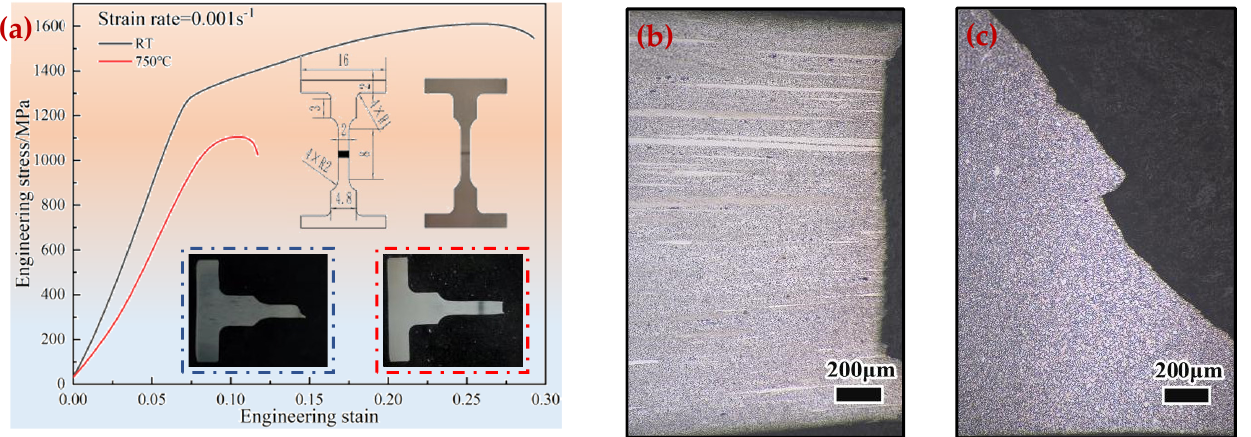
Figure 8. ( a ) Stress − strain curve of GH4065A alloy IFW joints at RT and 750 °C, ( b ) Microstructure of IFW joint fractured at RT, ( c ) Microstructure of IFW joints fractured at 750 °C.